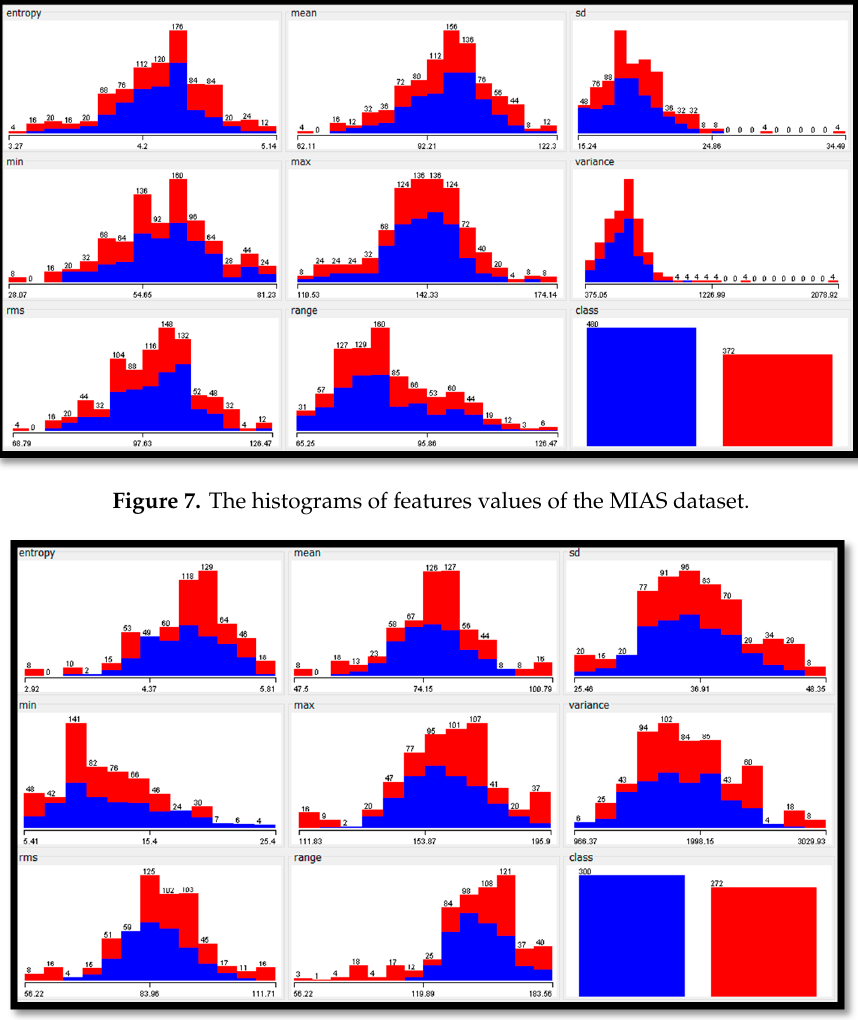
Figure 8. The histograms of features values of the digital mammography dream challenge dataset.